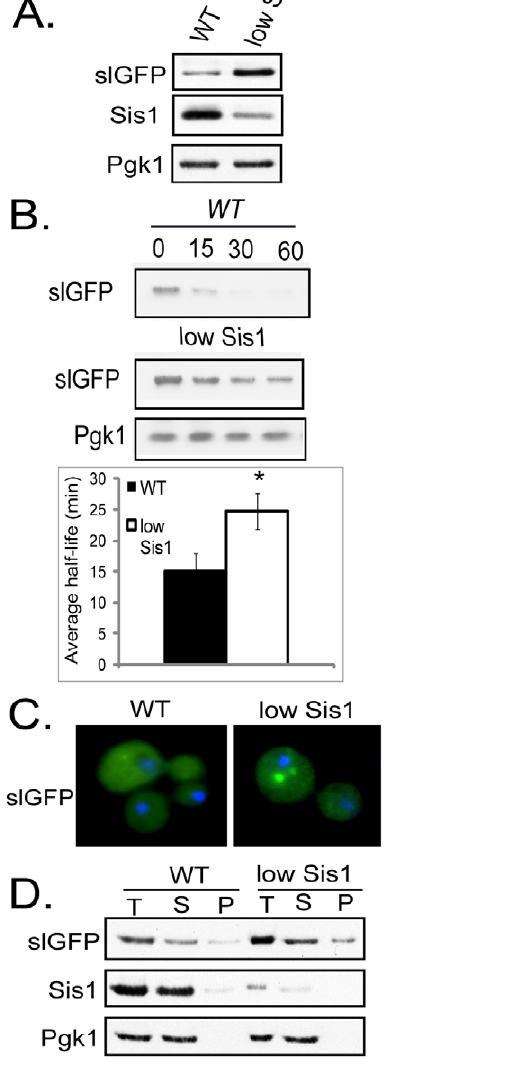
Figure 4. Reducing Sis1 Levels Stabilizes SlGFP and Induces SlGFP Accumulation in Puncta. A) Steady-state slGFP levels in an isogenic WT strain and D sis1 complemented with SIS1 expressed from a plasmid under control of the doxycycline-repressible promoter (low Sis1). B) Cycloheximide-chase analysis of slGFP turnover in indicated strains. Quantification of the half-life of slGFP in a WT or low Sis1 strain. Error bars represent the SEM for three independent experiments. C) Fluorescence microscopy of slGFP localization. D) Triton X-100-solubility of slGFP.